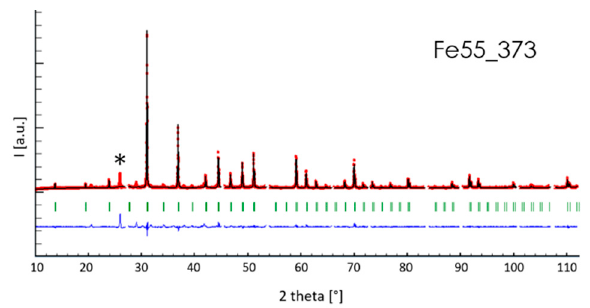
Figure 3. Rietveld refinement plot of sample Fe55_373. The red and black lines are the experimental and the calculated di ff ractograms, respectively; the lower blue line is the di ff erence curve; green vertical bars indicate the calculated positions of Bragg peaks of the filled skutterudite; the asterisk indicates the presence of a small amount of an unknown compound. Angular regions corresponding to the positions of Ge peaks were excluded.